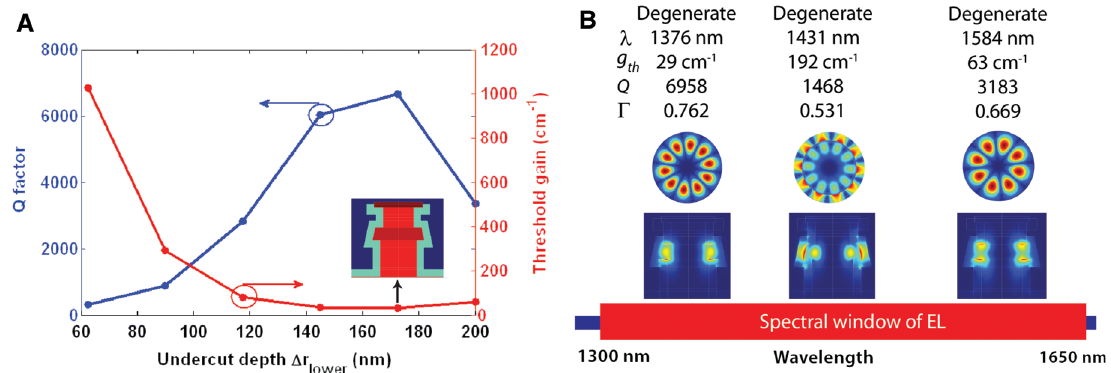
, cavity Q-factor, and the sidewall of the structure with the lowest g th < 200 cm -1 , for the device geometry shown in (A). (Reprinted th